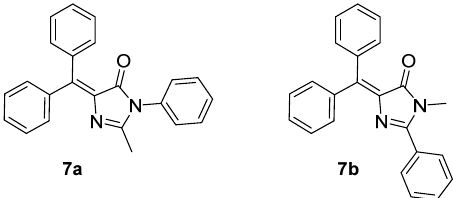
Figure 7. GFPc analogues without Z /E isomerization [21].